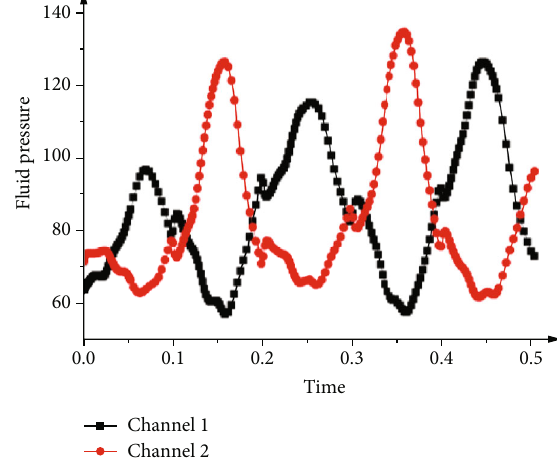
Figure 8: Fluid pressure change of two